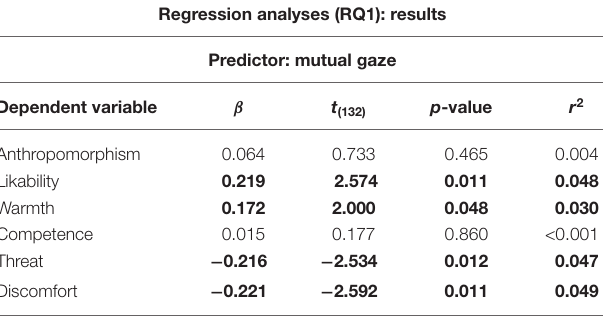
TABLE 6 | Results of the regression analyses performed for RQ1. Regression analyses (RQ1): results